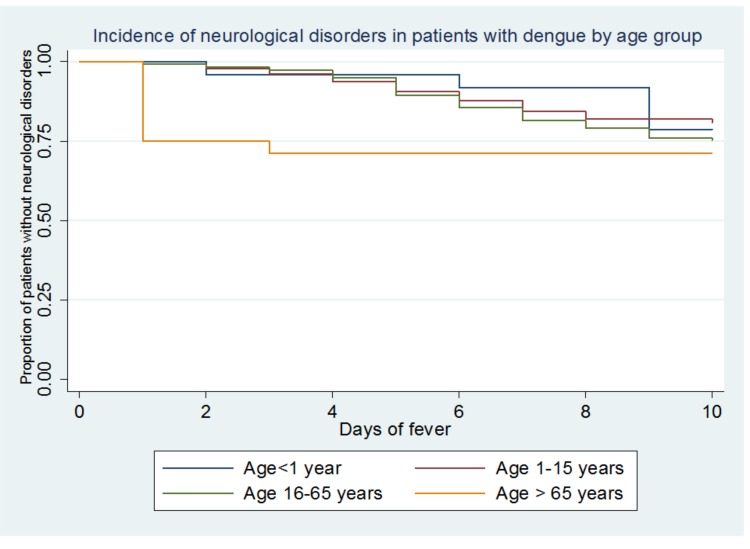
“Kaplan Meier curve for neurological disorder during dengue fever by age group”.